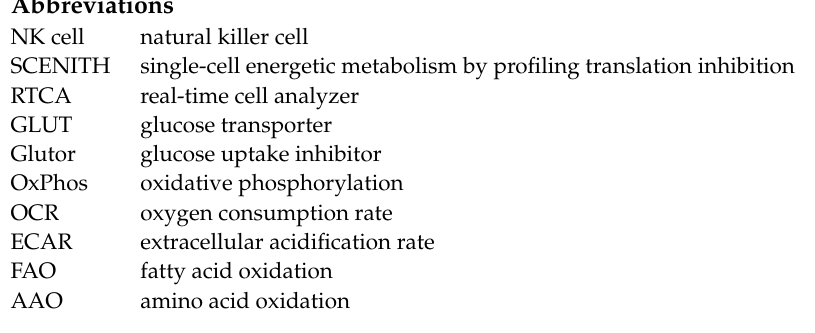
Figure S3: RNA sequencing results; Figure S4: Inhibition of Glutaminase and glucose transporters results in cell death of NK